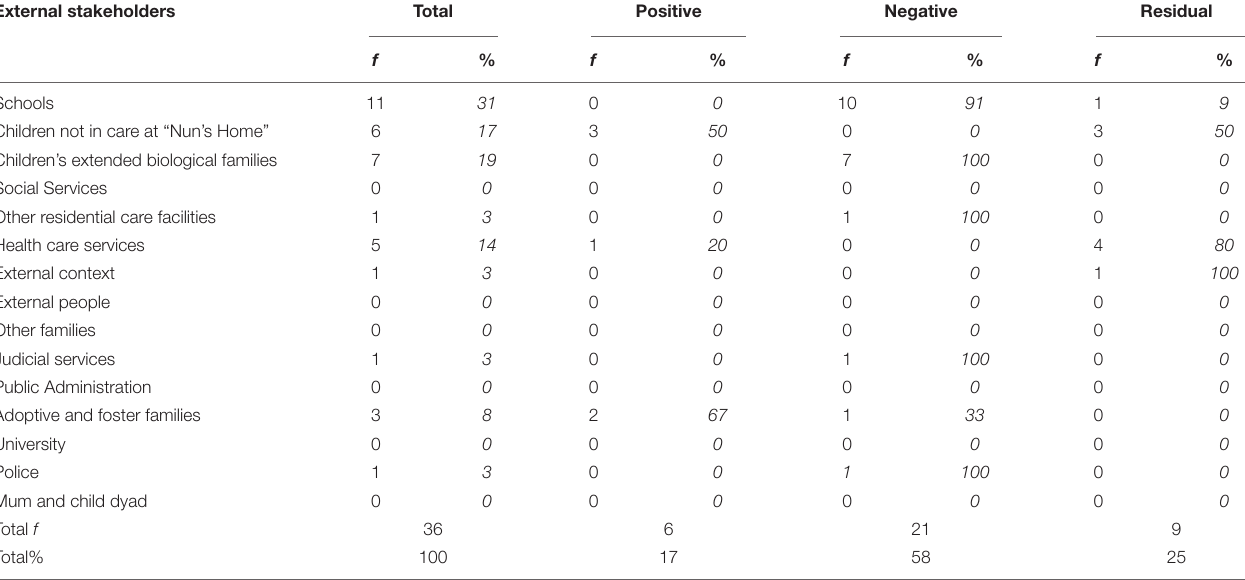
Italic indicates difference between frequencies and percentage values. TABLE 4 | Frequency and percentage of external stakeholder (outgroup) qualifying